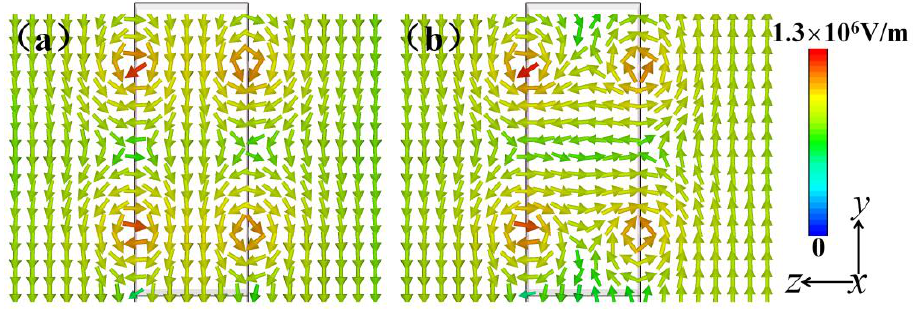
Figure 3. Electric field distributions in the y-z plane ( x = L/2) for ( a ) f 1 and ( b ) f 2 .